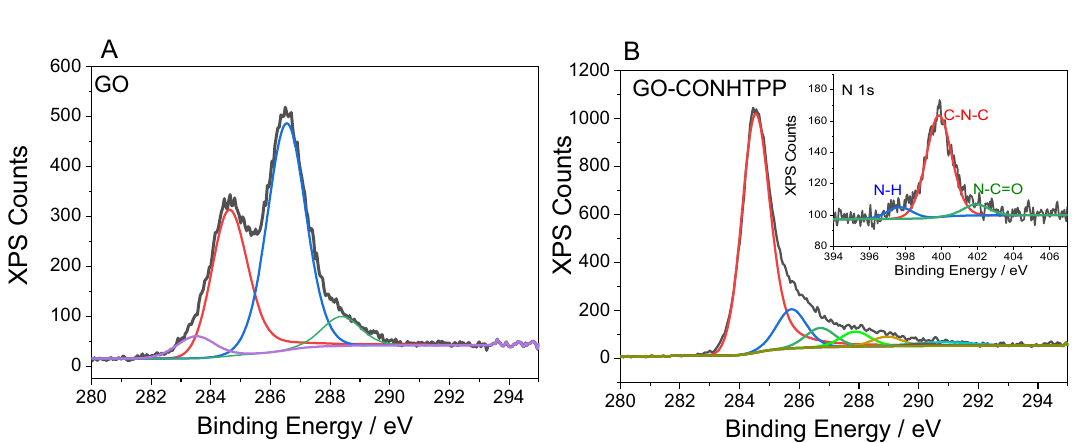
Figure 2. XPS spectra of C1s for ( A ) GO and ( B ) GO-CONHTPP and N1s for GO-CONHTPP in the